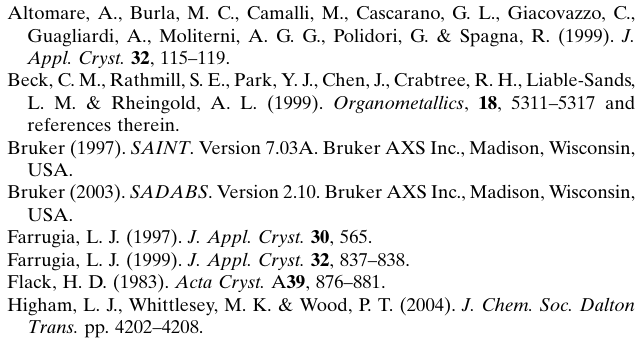
Bruker X8 APEXII diffractometer Absorption correction: multi-scan